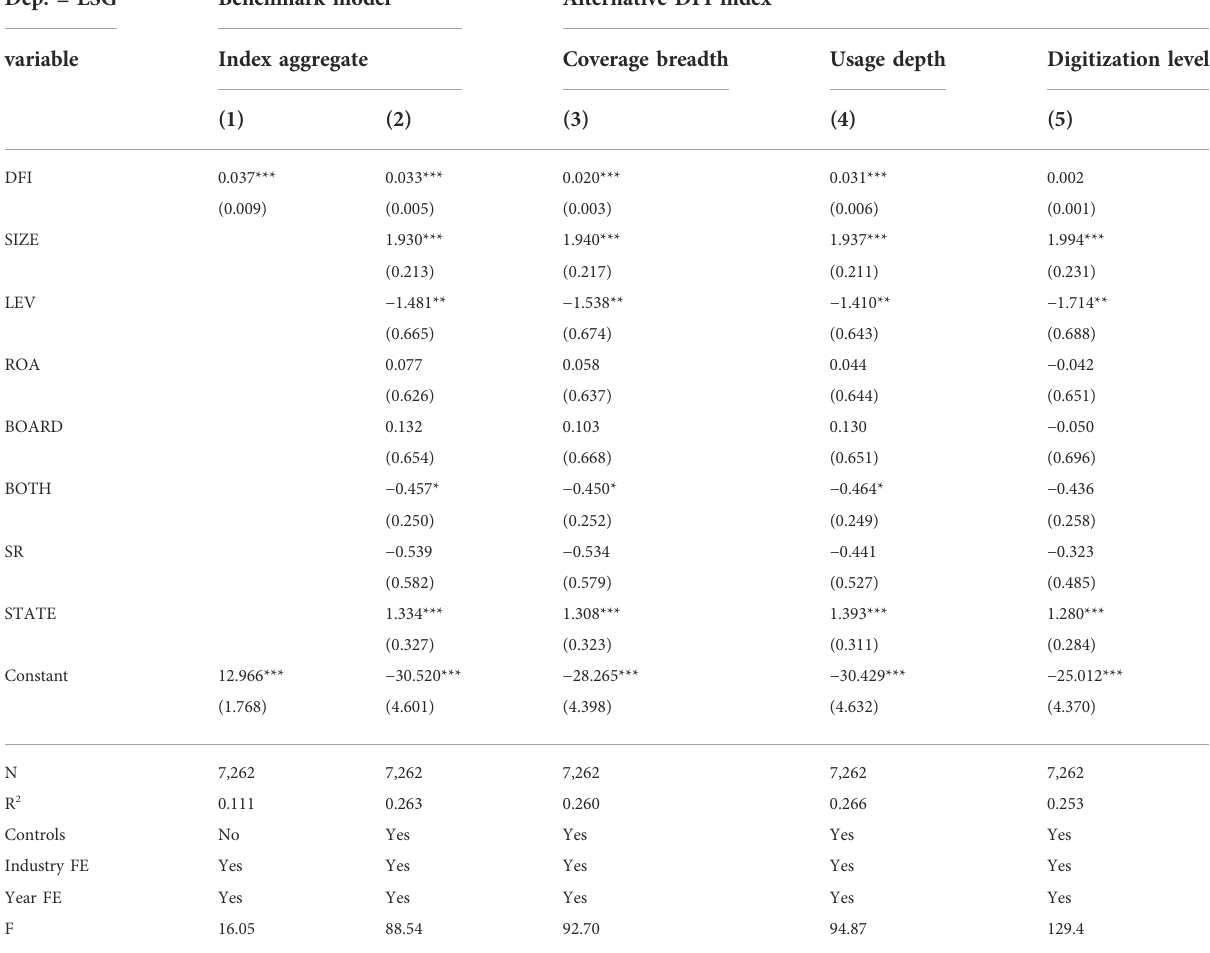
TABLE 3 Baseline regression results. Dep. =